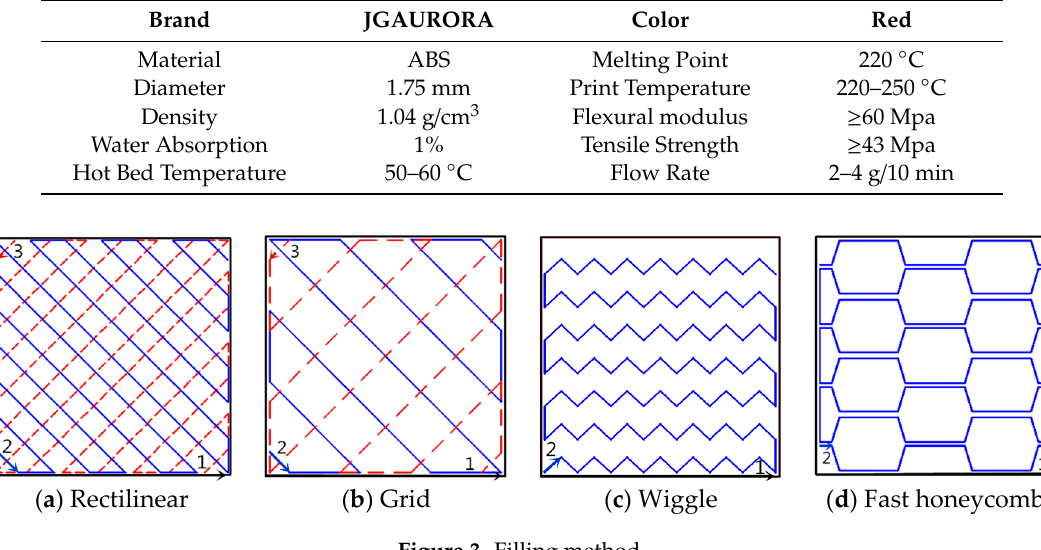
Table 2. Characteristics of acrylonitrile butadiene styrene (ABS) printing materials.